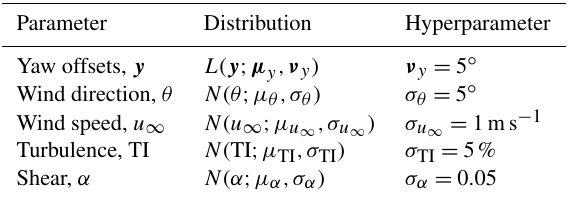
Table 2. Probability distributions and hyperparameter values de- scribing the uncertainty associated with various inputs to the wake